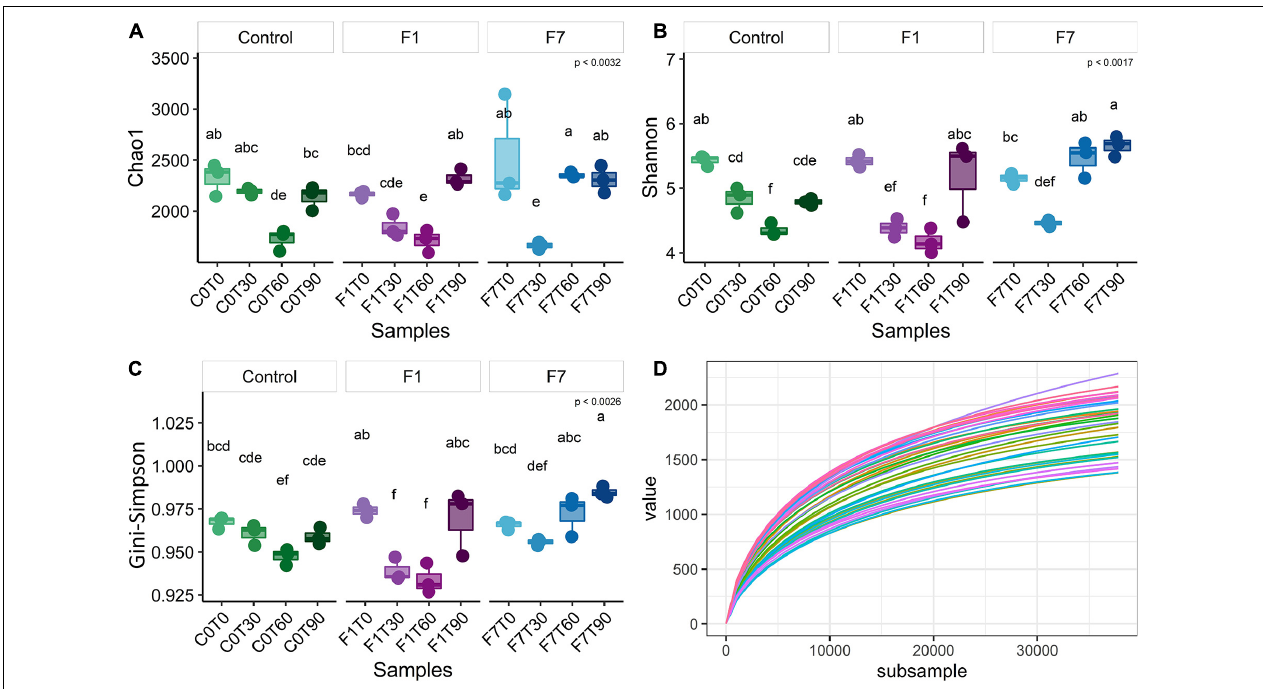
FIGURE 2 | (A) Chao1 index, (B) Shannon index, (C) Gini–Simpson index (1- λ ), and (D) rarefaction curves of observed species of bacterial community composition. Each sample was rarefied at 37,809 counts, and the distribution of three biological replicates per sample is reported. Box and whiskers hinges represent the first and third quartiles, upper and lower whiskers represent the furthest datapoints from median. Reported p -value is calculated by Kruskal–Wallis test ( α = 0.05). Group letters represent statistical significance at α = 0.05, based on Fisher LSD post-hoc test, with Benjamini–Hochberg correction for multiple comparisons: groups sharing one or more letters are not significantly